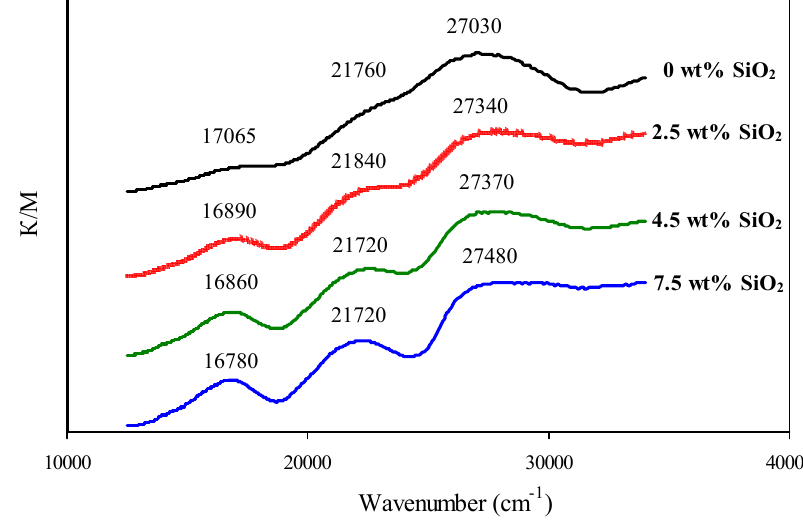
Figure 10. Diffuse reflectance UV ‐ Vis ‐ spectra of catalysts (6.5 wt% Cr; 0.8 wt% K).